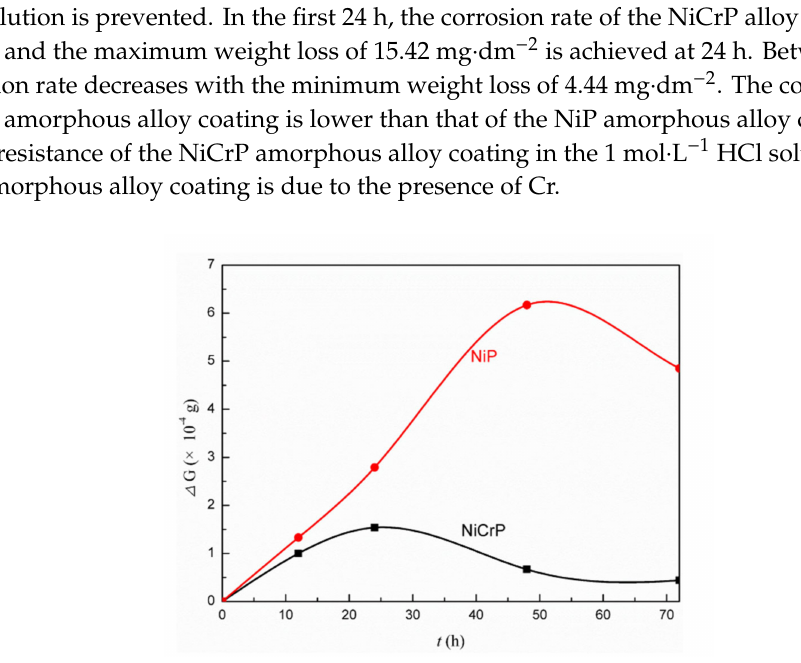
Figure 12. Relationship between the time and corrosion weight loss of the alloy coatings in a 1 mol · L − 1 HCl